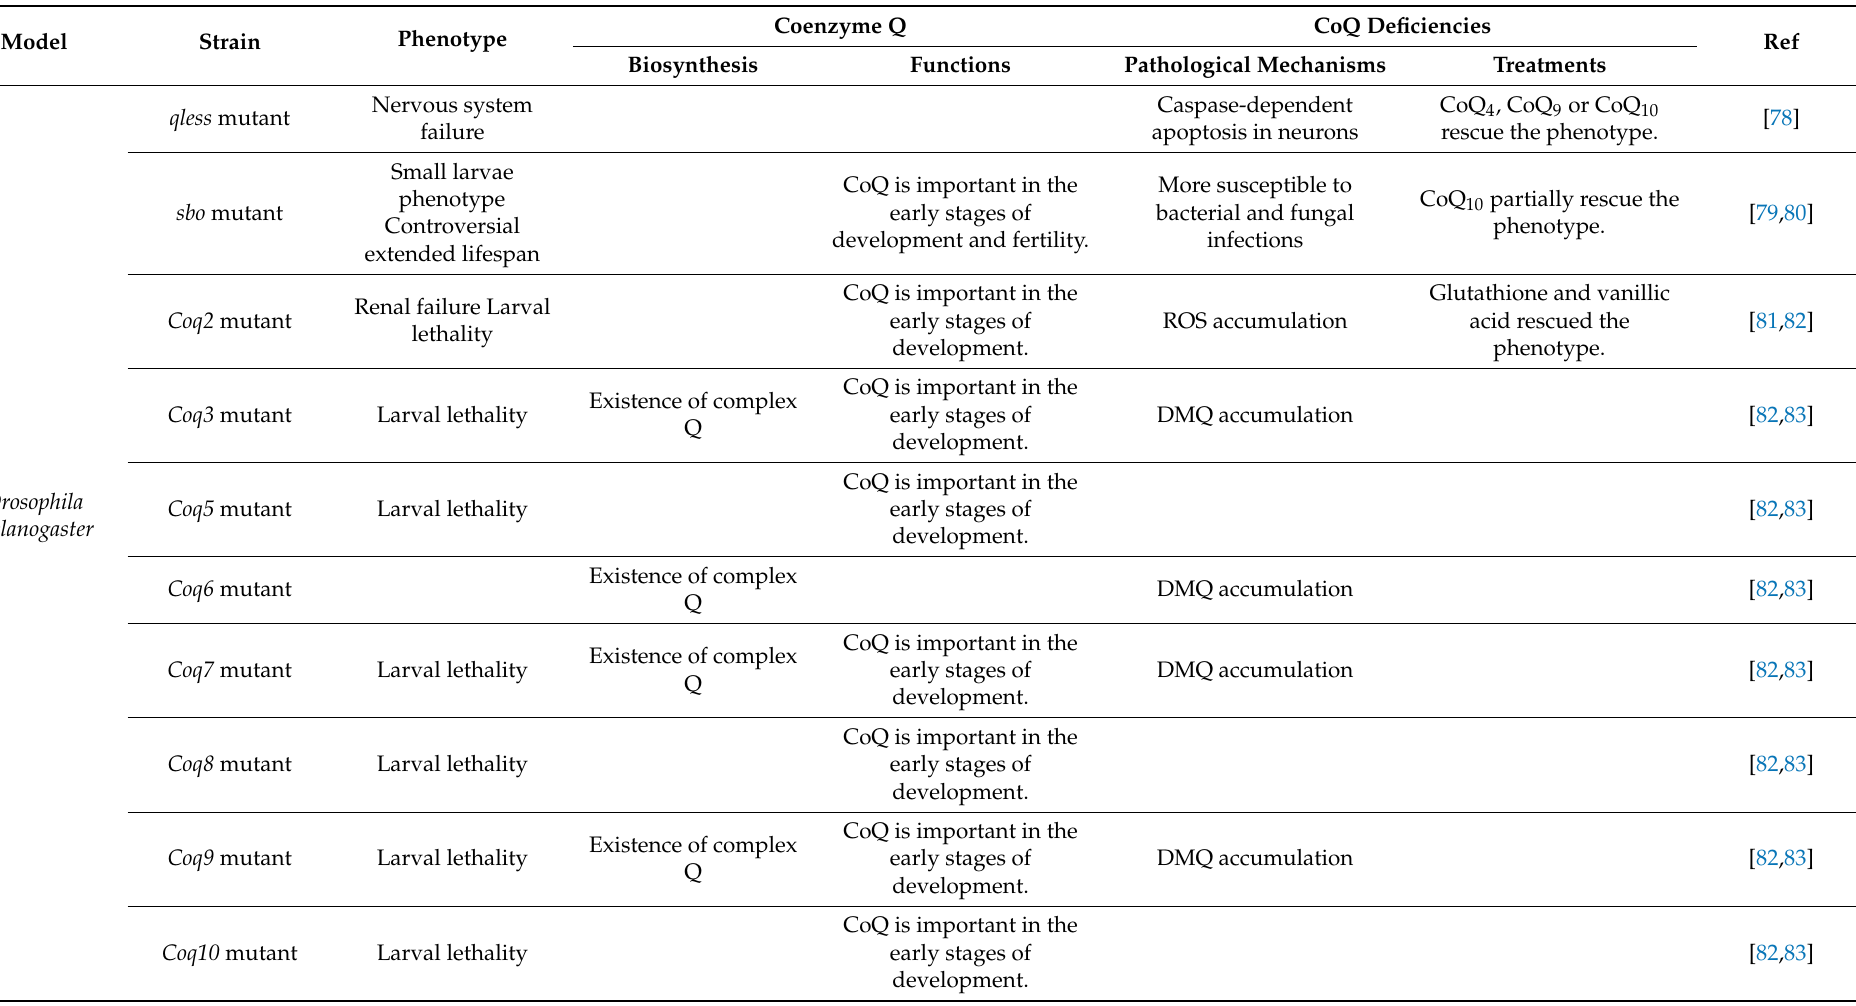
Table 1. Overview of the animal models of CoQ deficiency mentioned, remarking their contribution to expand the knowledge about the CoQ biosynthetic pathway and functions, and the pathomechanisms and treatments related to CoQ